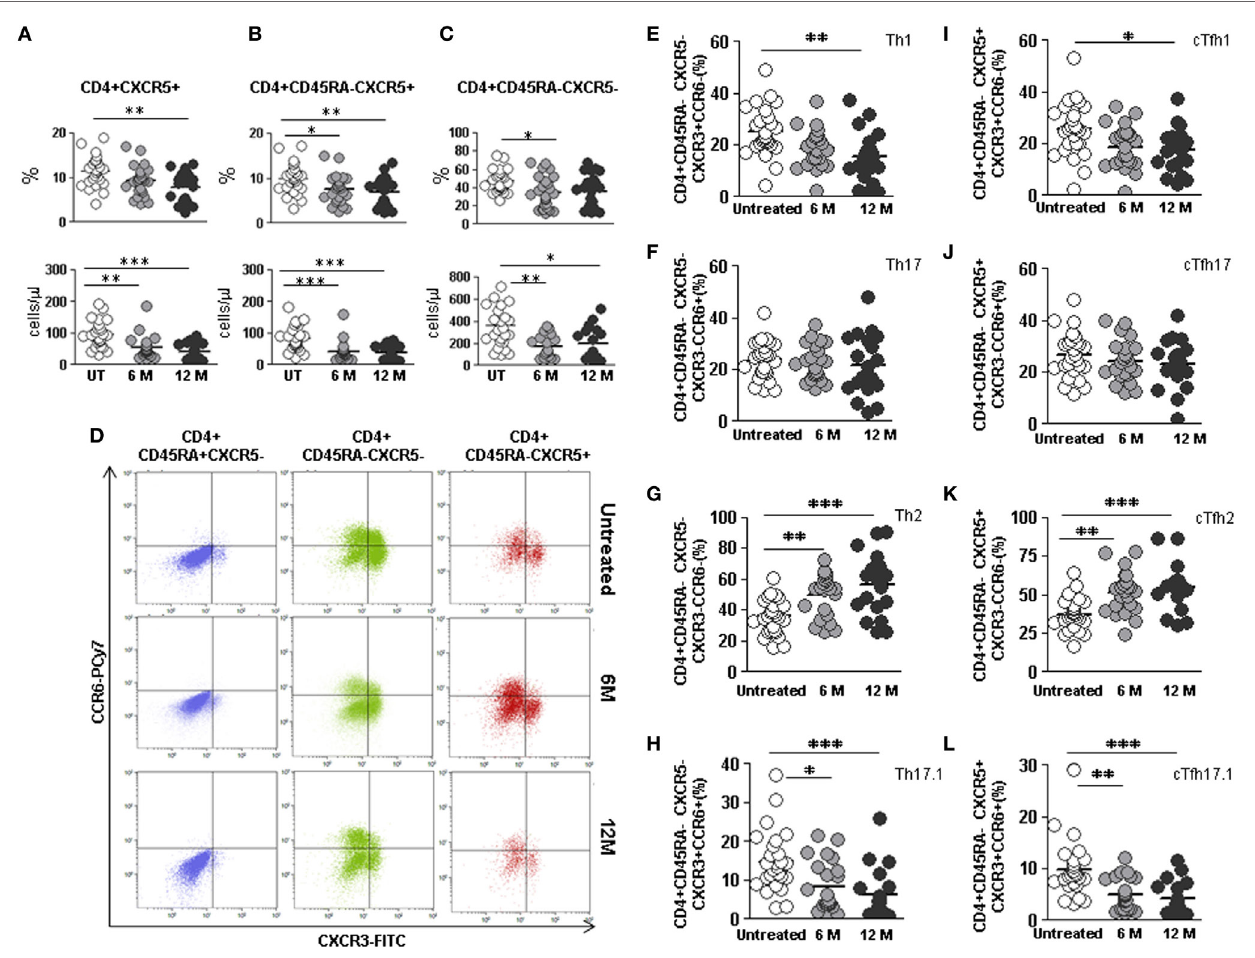
FigUre 5 | Effect of dimethyl fumarate on total cTfh cells and subpopulations of Th and cTfh cells from multiple sclerosis (MS) patients. (a–c) Total follicular CD4 + CXCR5 + , memory follicular CD4 + CD45RA − CXCR5 + , and memory non-follicular CD4 + CD45RA − CXCR5 − percentages (upper panels) and cell counts (lower panels) from untreated (white circles), 6 months treated (6 M: light gray circles), and 12 months treated (12 M: dark gray circles) MS patients. (D) Dot-plots of the percentage of Th1 CXCR3 + CCR6 − (lower right quadrant), Th17 CXCR3 − CCR6 + (upper left quadrant), Th2 CXCR3 − CCR6 − (lower left quadrant), and Th17.1 CXCR3 + CCR6 + (upper right quadrant) subpopulations on circulating naïve CD4 + CD45RA + CXCR5 − (left), non-follicular CD4 + CD45RA − CXCR5 − (middle), and follicular CD4 + CD45RA − CXCR5 + (right) cells from a representative untreated (upper row), 6 months treated (6 M: middle row), and 12 months treated (12 M: lower row) MS patient. (e–h) Percentages of Th1, Th17, Th2, and Th17.1 non-follicular T cells and (i–l) cTfh1, cTfh17, cTfh2, and cTfh17.1 follicular T cells from untreated (white circles), 6 months treated (6 M: light gray circles), and 12 months treated (12 M: dark gray circles) MS patients. Kruskal–Wallis test p -values: * p < 0.05, ** p < 0.01, and *** p <